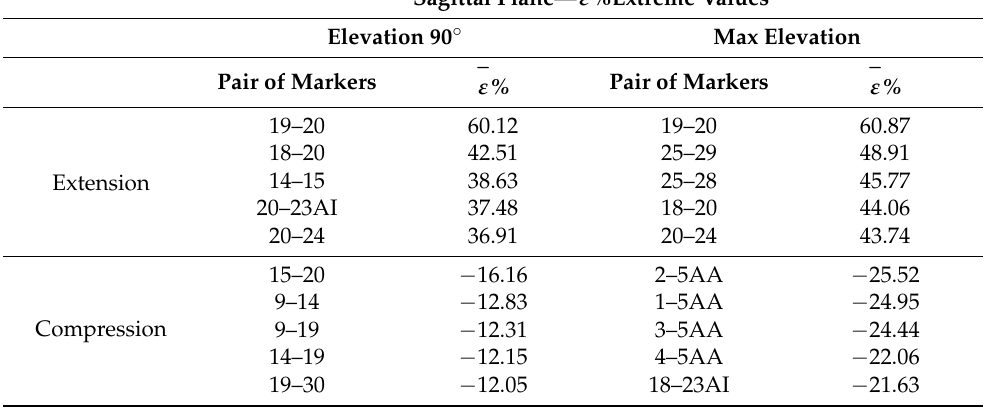
Table 4. Extreme percentage values of the mean strain ε % in both extension and compression during tasks performed in the sagittal plane.